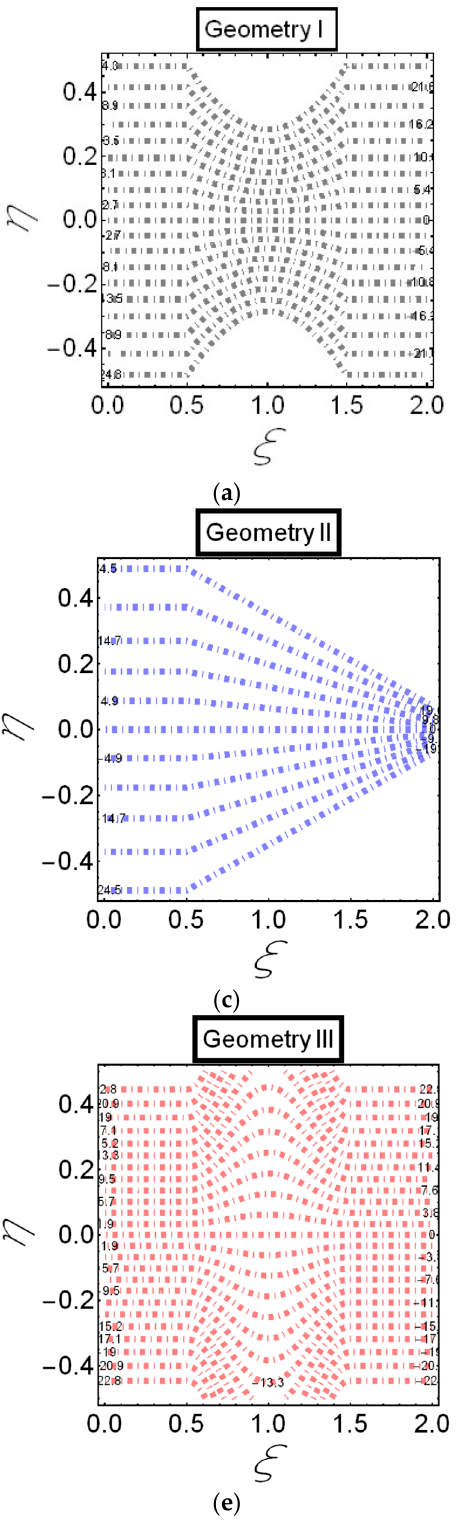
Figure 14. Streamlines for Uhs = 2 ( a , c , e ) and Uhs = 5 ( b , d , f ).